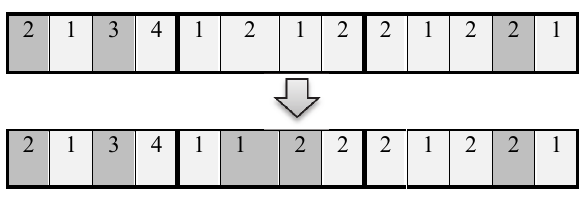
Fig. 6. A chromosome with 4 machines and 5 parts